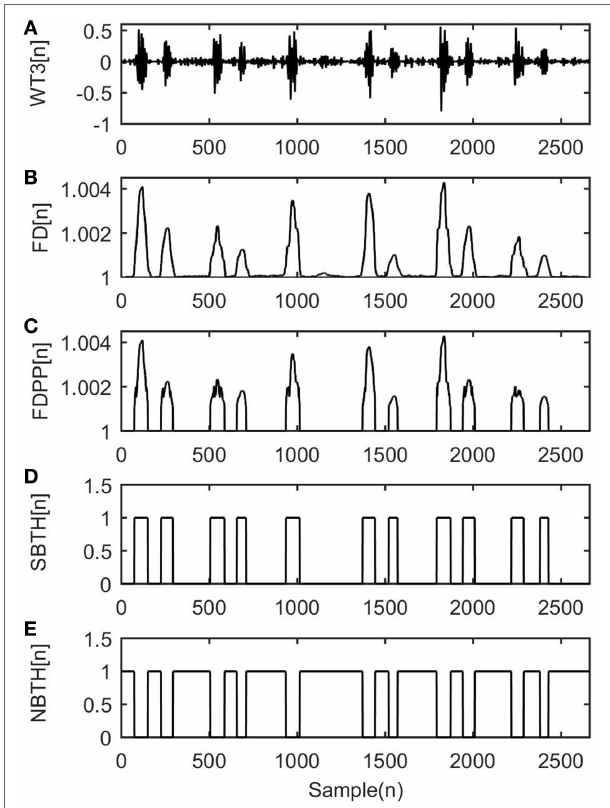
FIGURE 2 | A working example of the production procedure of the binary thresholds SBTH 1 3 and NBTH 1 3 derived from the application of the wavelet transform (WT)–fractal dimension (FD) filter to a case of fetal phonocardiograph recording. These results refer to scale j = 3 and iteration k = 1 during the application of the WT–FD filter to the input signal. (A) WT 3 , the third WT coefficient, (B) FD 1 3 , the estimated FD using Katz’s definition by Eq. 2, (C) FDPP 1 3 , the output of the FD-peak peeling algorithm, (D) SBTH 1 3 ; the signal binary threshold, and (E) NBTH 1 3 , the noise binary